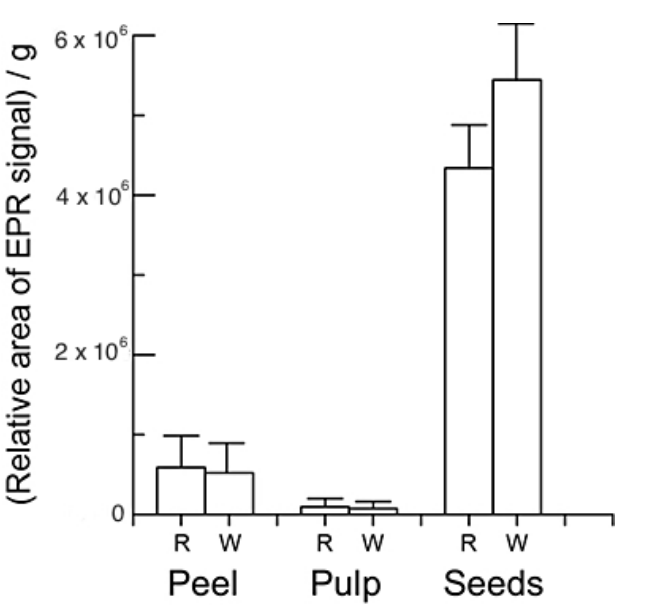
Figure 9. Bar plot showing the relative areas of EPR signals as a function of the part of the dragon fruit used. The area of each EPR spectrum was obtained by the double integral. The results are expressed as the mean ± standard error. The letters (R and W) represent red and white, respectively.